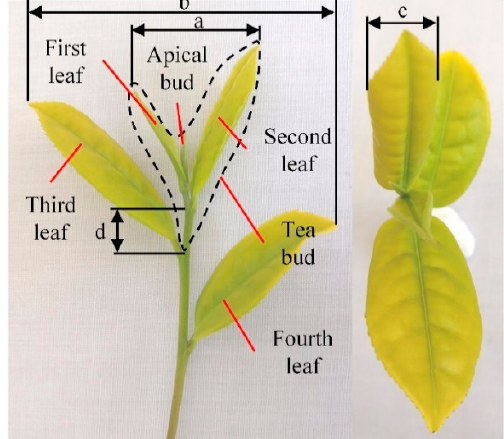
Figure 1. Schematic of tea characteristic parameters. Overall dimension: a—first leaf span, b— second leaf span, c—leaf width, d—node spacing.